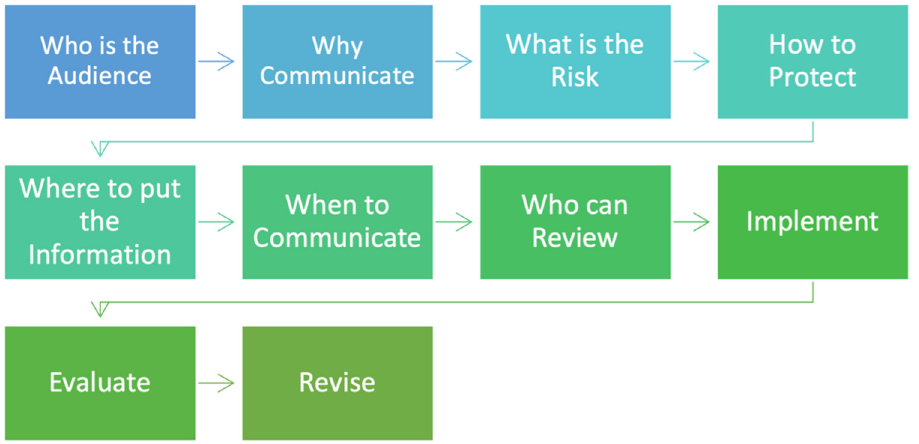
Figure 5. Risk and Safety Communications Model.